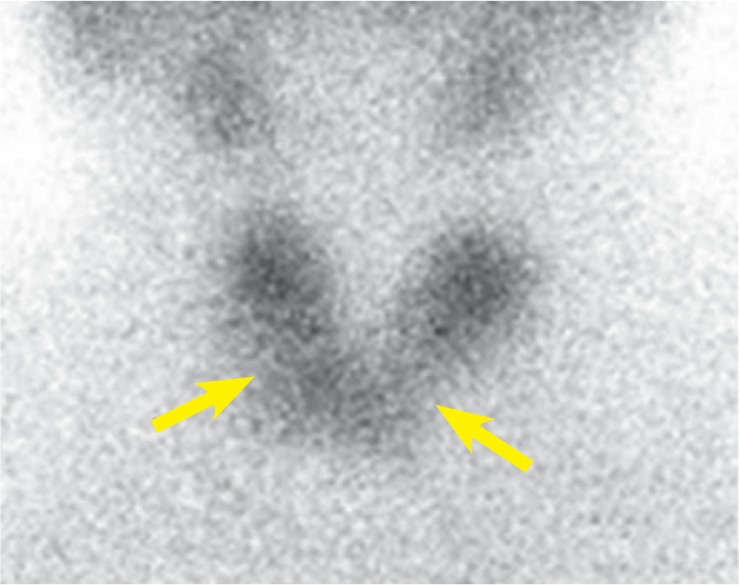
99mTcO4 scan showing “cold” nodules in the both thyroid lobes.